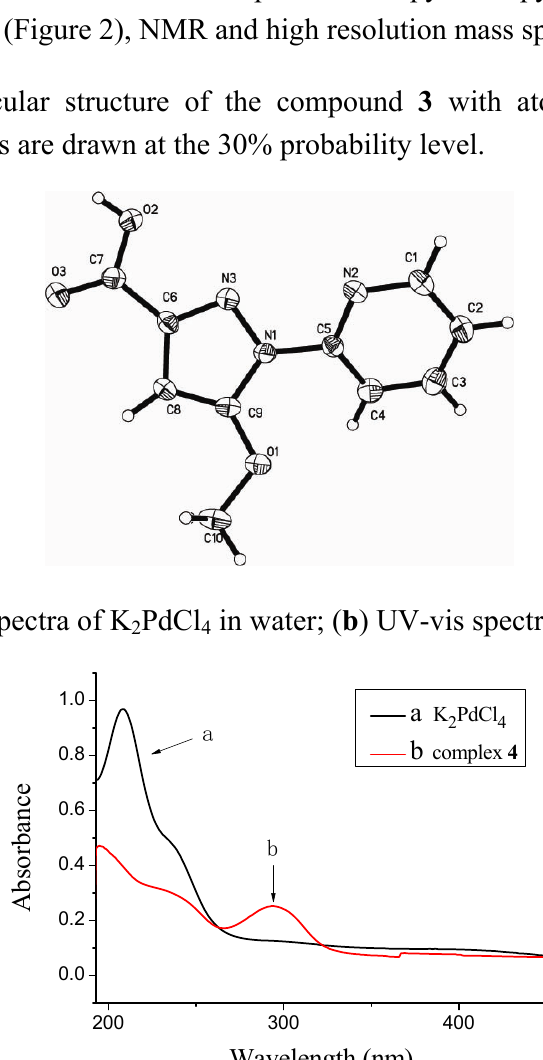
Figure 1. The molecular structure of the compound 3 with atom-numbering scheme, displacement ellipsoids are drawn at the 30% probability level.